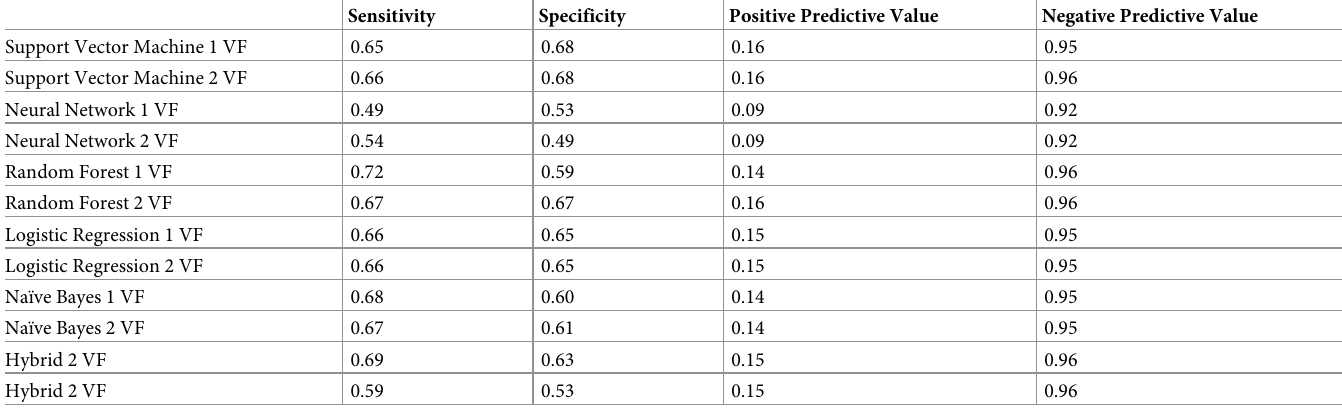
Table 3. Model performance metrics.